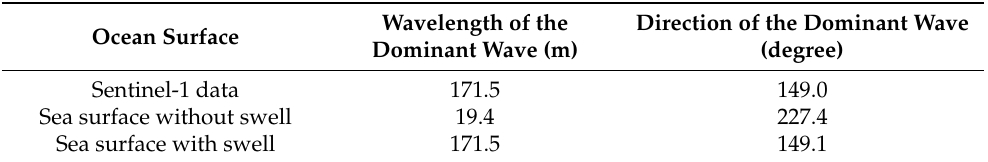
Table 2. The wavelength and direction of dominant wave obtained from the scattering image spectra in Figure 18.